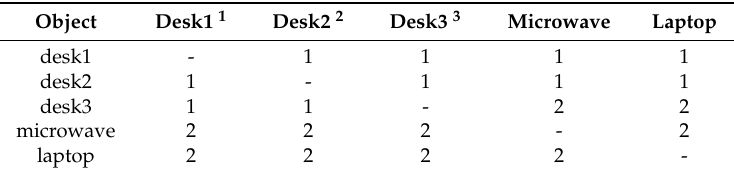
Table 2. Navigation goal in o ffi